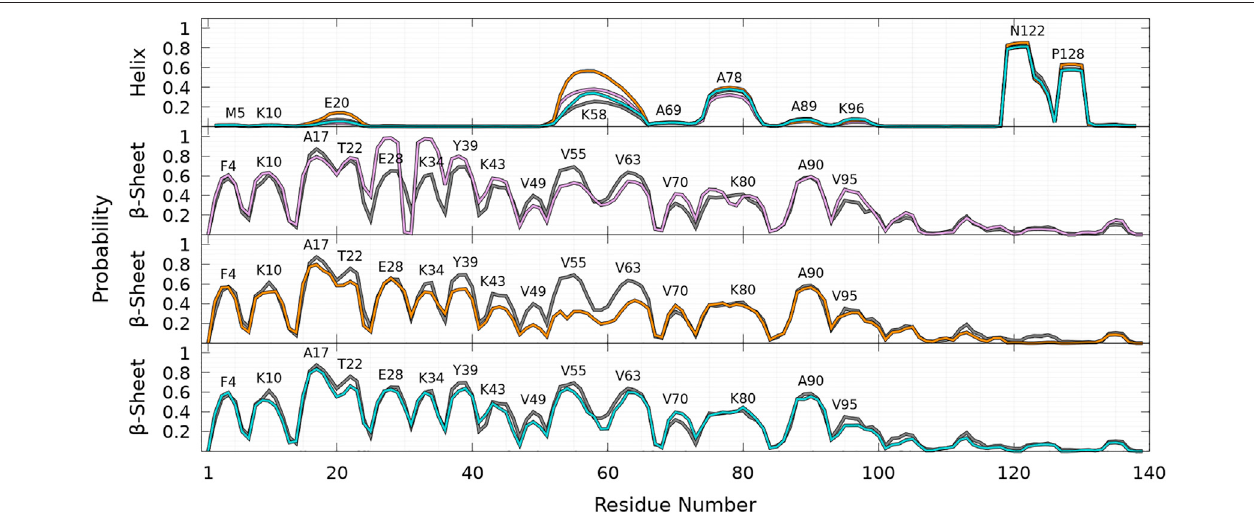
FIGURE 8 | Probability of each residue to pertain to an α -helix (top panel) and a β -sheet (other panels) for WT (gray), A30P (purple), A53T (orange), and E46K (turquoise)asafunction ofthe residue positionin thesequence. Forthe β -sheet,each mutant iscompared toWT (gray) withlabels pointing outresidues atlocal maxima of the WT probability densities.